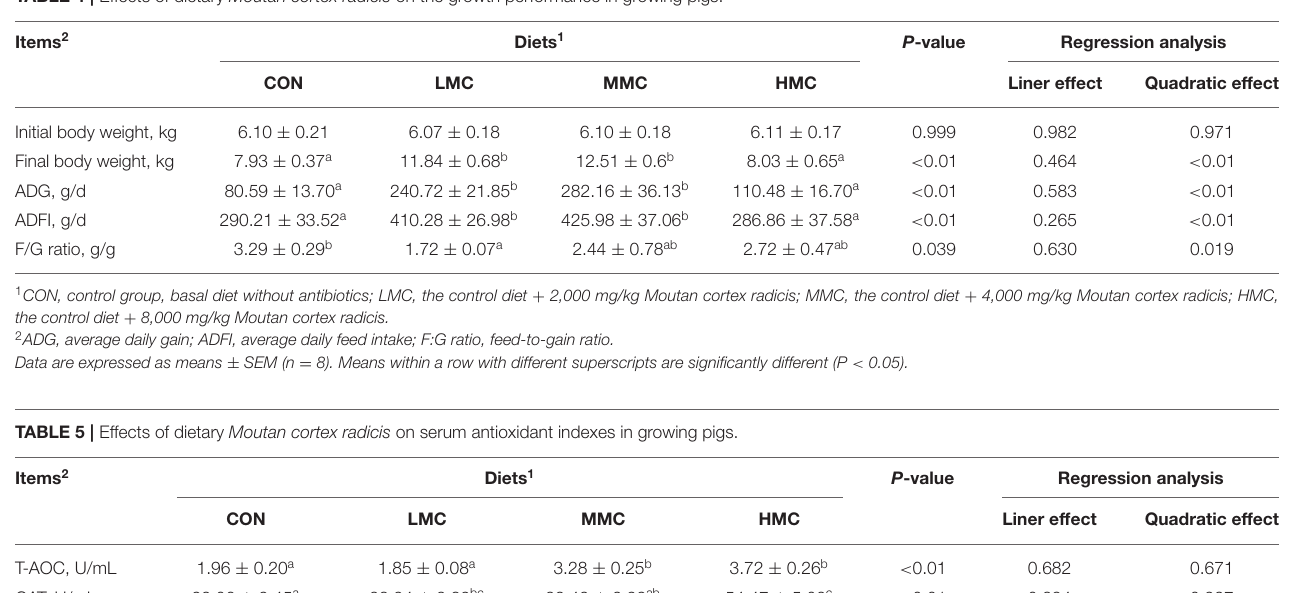
TABLE 4 | Effects of dietary Moutan cortex radicis on the growth performance in growing pigs.